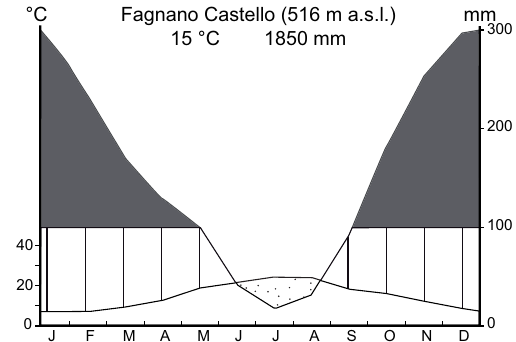
Fig. 3. Ombrothermic diagram of the meteorological station of Fag- nano Castello, about 3km away from Lago Trifoglietti. This station is on the eastern side of the mountain range, and the record ran for 42yr (1921–1968; Ciancio,